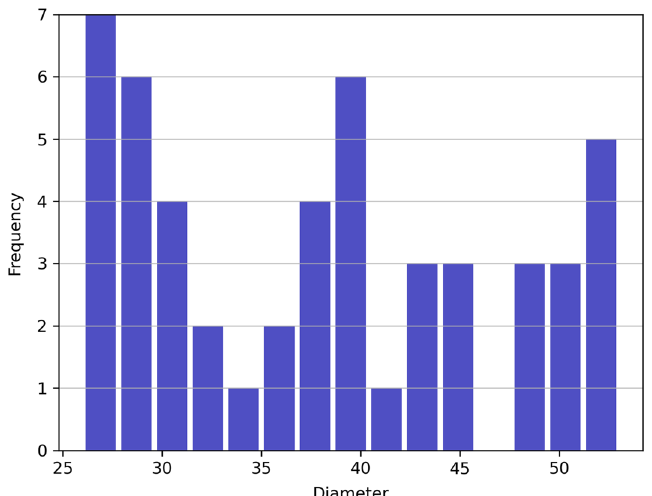
Fig. 2 Diameters of random graphs. We use a binwidth of 2